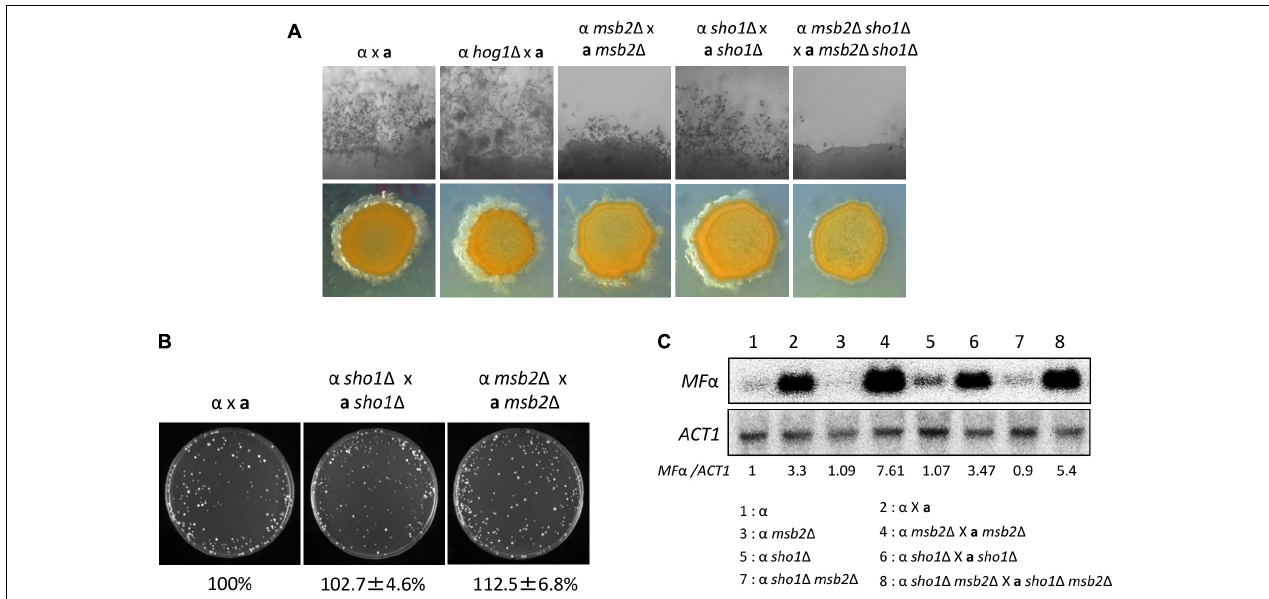
FIGURE 7 | Sho1 and Msb2 play redundant positive roles in the filamentous growth of C. neoformans . (A) Opposite mating type ( MAT α and MAT a ) cells were incubated for 16 h in YPD liquid medium at 30 ◦ C. Opposite mating type cells were mixed at equal concentration (10 7 cells/mL), spotted (5 µ L) on V8 medium, and further incubated in the dark at room temperature for 2 weeks. This mating experiment was repeated twice and one representative image was shown here. (B) Mixed opposite mating type cells were spotted on V8 medium and incubated for 1 day at room temperature in the dark. After cells were grown on V8 medium, the cells were resuspended in 1-mL dH 2 O and diluted to 1/100. Then, 200 µ L of the suspension was spread on YPD medium containing nourseothricin and G418. The plates were further incubated at 30 ◦ C and colonies were counted. (C) The northern blot analysis was performed with total RNAs from strains grown on V8 medium for 18 h. The northern blot membrane was hybridized with the mating pheromone-gene ( MF α 1 )-specific probe. This northern blot analysis was repeated twice and one representative result was shown here.